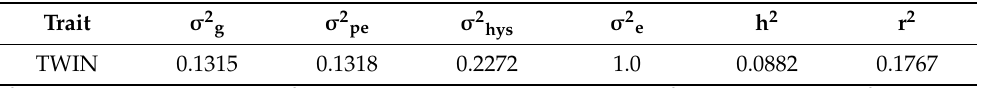
Table 3. Estimated variance components for twinning in